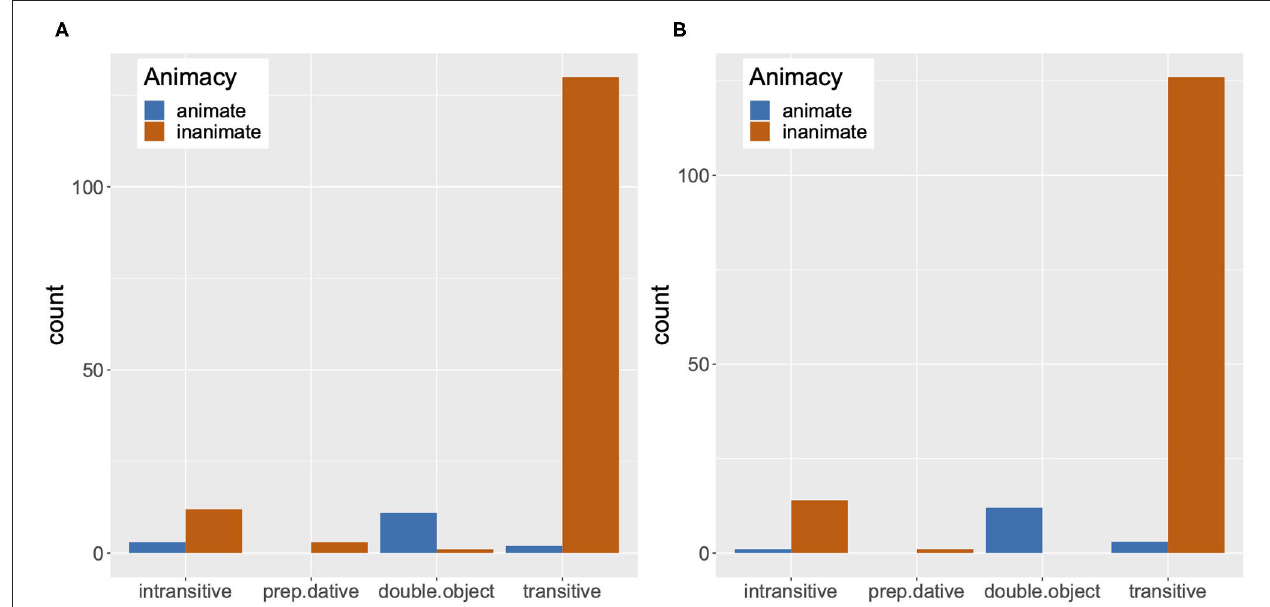
FIGURE 8 | Frequency counts of argument structures grouped by animacy for the expressions provided by participants in the single/double match condition, Experiment 3. (A) Double Match. (B) Single Match.